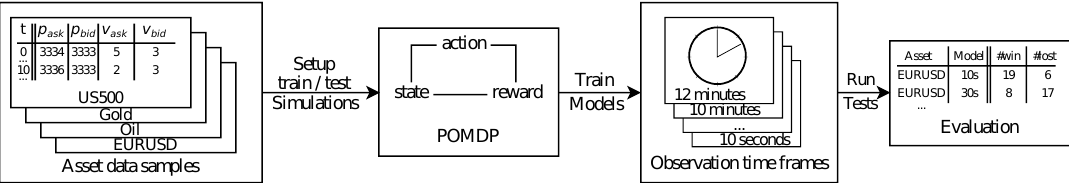
Figure 3. A sketch of the whole workflow setup for sampling, training and